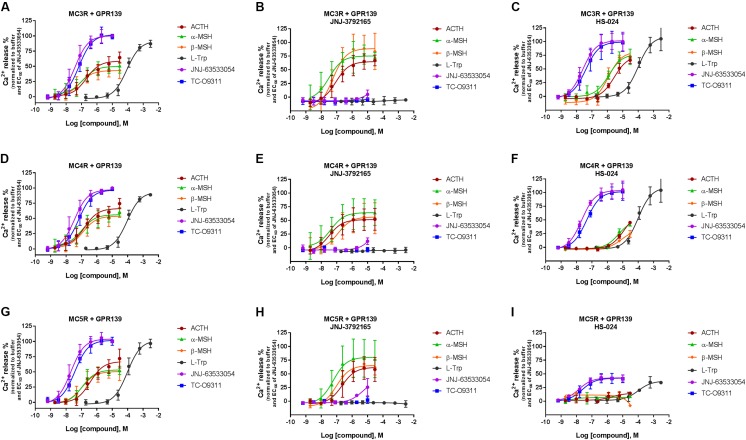
Inhibition of ACTH, α-MSH, β-MSH, L-Trp, JNJ-63533054, or TC-O9311 induced calcium release in HEK-293 cells transiently co-expressing GPR139 and MC3R (A–C), MC4R (D–F) or MC5R (G–I) by a GPR139 antagonist (10 μM JNJ-3792165, B, E, H) or a MCR antagonist (1 μM HS-024, C, F, I). Data are the mean ± SEM of at least three separate experiments performed in duplicates.